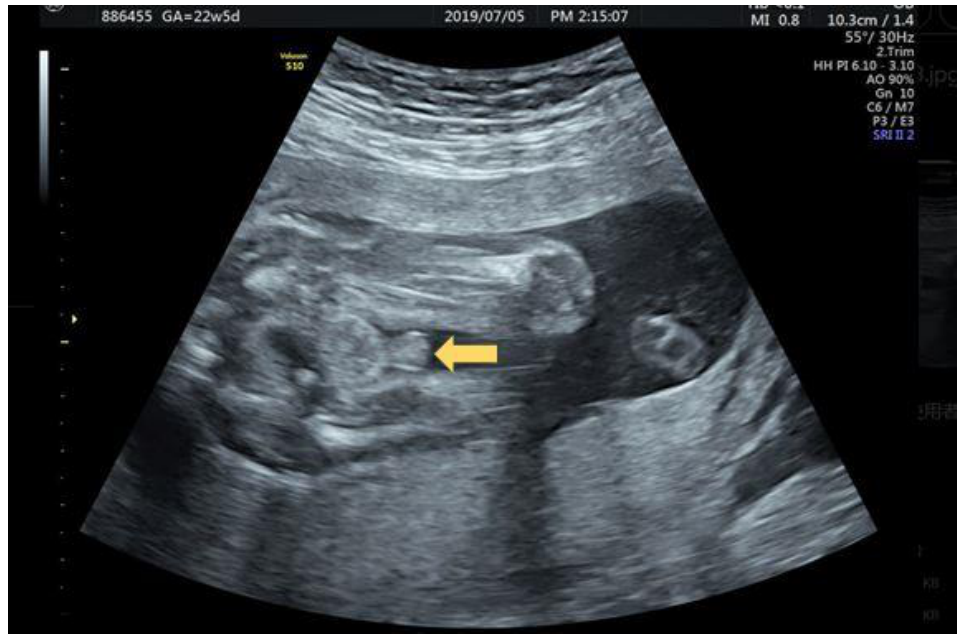
Figure 2. 32 year old G3P1A1 GA 22 + 5 weeks with “blunt” instead of taper “pointed” penis tip (arrow).